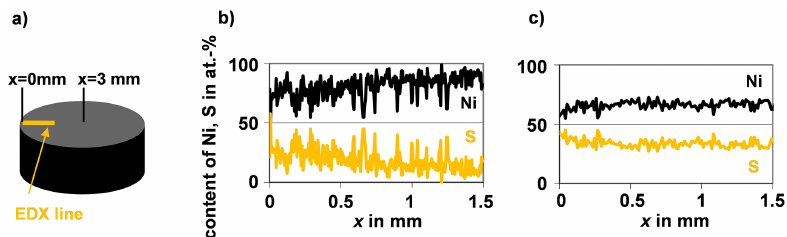
Figure 4. EDX: (a) sketch of the EDX line scan direction; (b) sample sulfidized for 6h at 100 ◦ C and 1000ppm H 2 S; (c) same conditions after sulfidation of